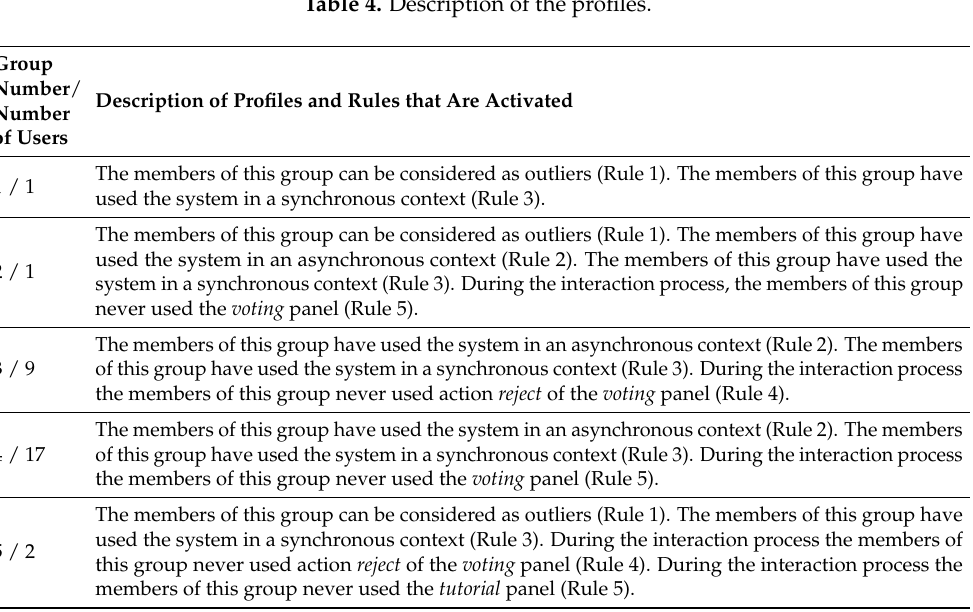
Table 4. Description of the